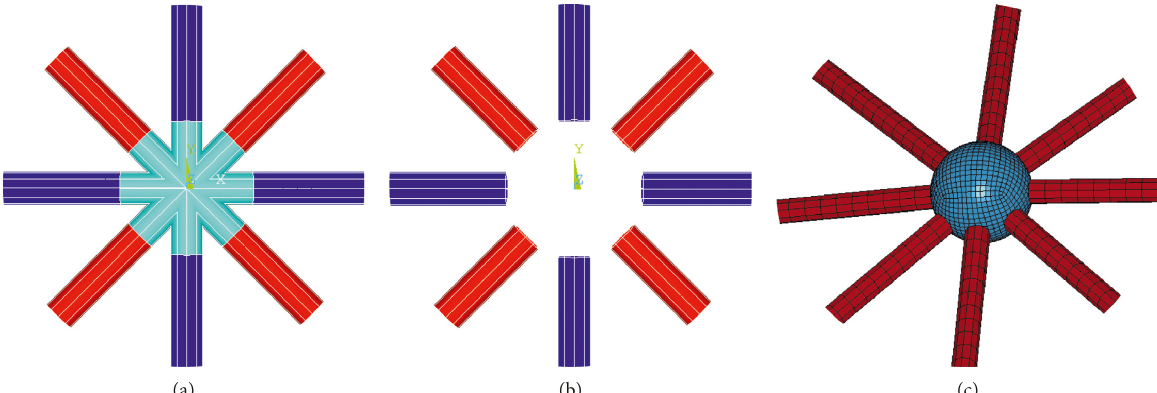
Figure 3: Process of connection between bars and spherical joints. (a) Boolean operation. (b) Deletion of redundant members. (c) Element mesh generation.